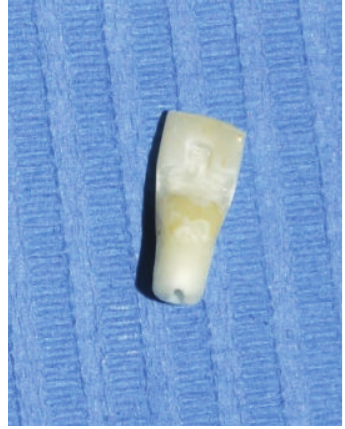
Figure 5: Pontic